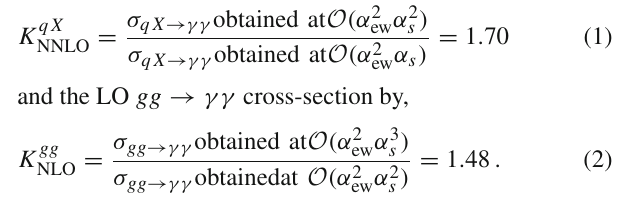
In other words, it shows the correction due to the top loop to the gluon fusion process. This ratio is found to be equal to unity for M γγ < 200 GeV. As M γγ increases, the ratio starts to decrease and shows a sudden dip at about M γγ = 2 m t